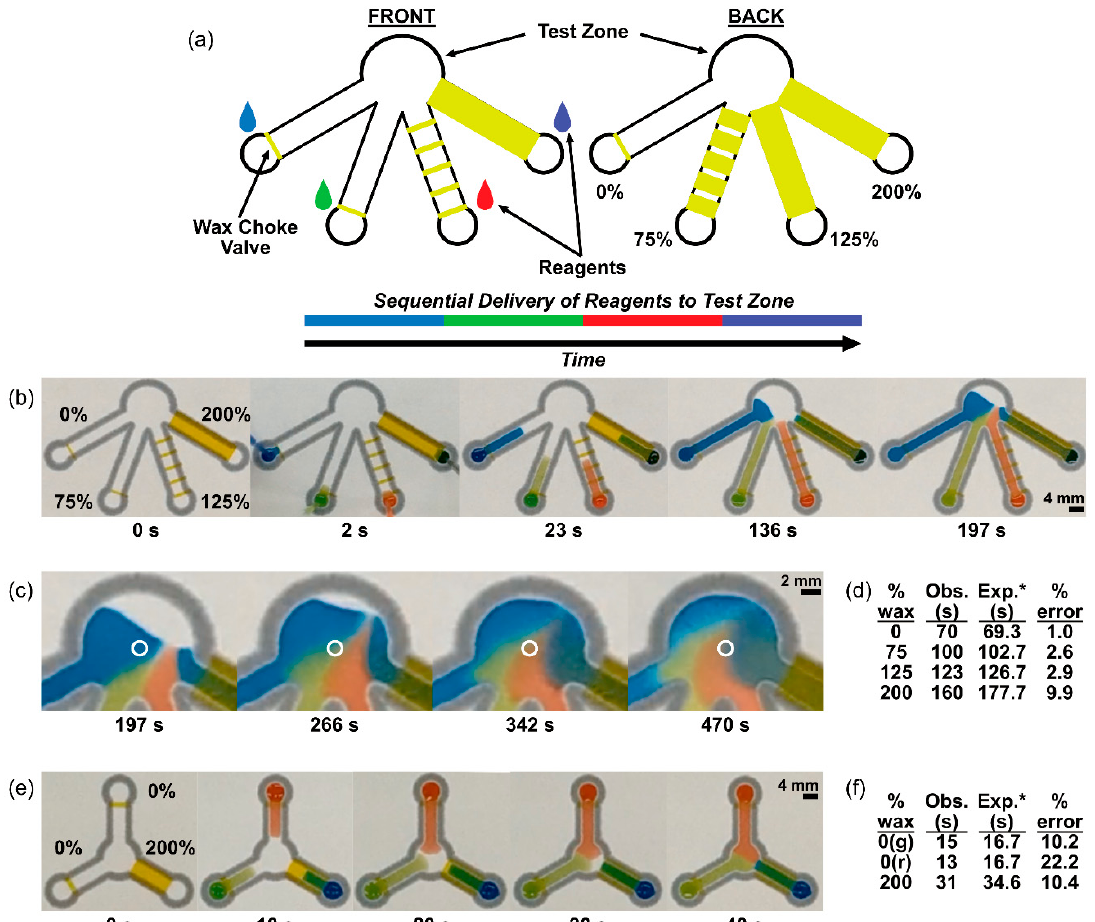
Figure 2. Sequential delivery of dyes to the test zone mediated by wax-printed fluidic time delays. ( a ) Conceptual diagram (front & back) of automated sequential delivery of reagents to a test zone. Wax-printed fluidic time delays depicted in yellow. The wax choke valve is used to direct the fluid into the paper channel. Colored dyes (8 µ L), added simultaneously to the fluid reservoirs, arrive at the central test zone in a timed sequence (see colored bar below diagram). ( b ) Time lapse images of sequential fluid delivery on a microPAD with 4 channels (15 mm × 4 mm) and 0–200% wax coverage (diagramed in part a ). Fluid applied to channels with lower wax percentages arrived first at the test zone. ( c ) Time lapse images of the test zone from the microPAD depicted in parts a and b . The four dyes arrive at the center of the test zone in the predicted sequential order, as indicated by the color of dye in the white circle at each time point. ( d ) Table of observed versus expected values for wicking times through each of the channels depicted in parts a – c . ( e ) Time lapse images of a microPAD with two channels with 0% wax coverage and one channel with 200% wax coverage (a total of three channels, each 7.5 mm × 4 mm) displaying the simultaneous arrival of two dyes (red & green) at the test zone from the 0% channels, followed by the later arrival of the third dye (blue) from the 200% channel. ( f ) Table of observed versus expected values for wicking times through each of the channels depicted in part e . Abbreviations: Obs. means observed, Exp. means expected, * means expected calculated based on the results from Figure 1c & Table A1. The dimensions of the channels and volumes of fluids used in the two experiments were different, however, these values allow for an approximate prediction of wicking time given the channel length and % wax